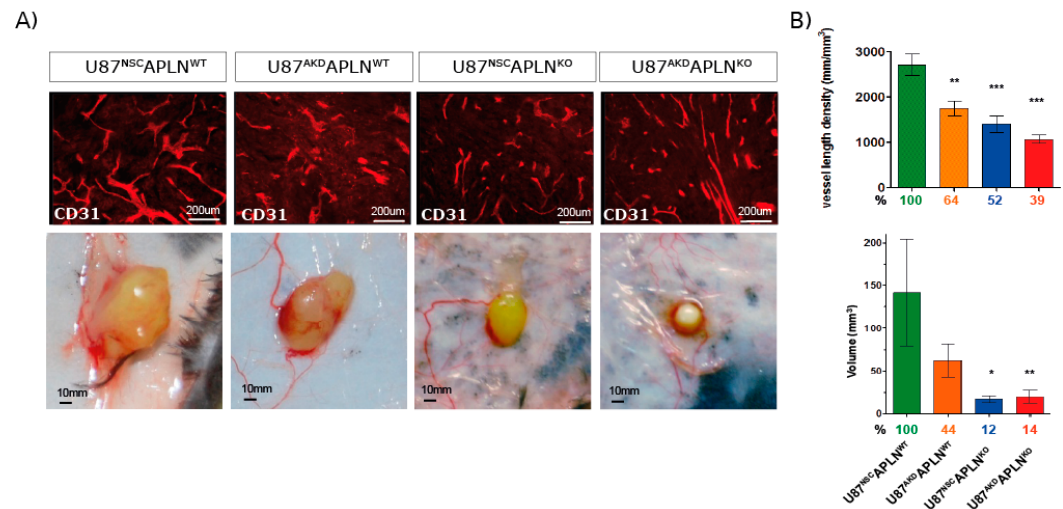
Figure 5. Apelin is required for compact tumor growth. Mice were inoculated subcutaneously with U87 cells and grown for 28 dpi. ( A ) Tumor volumes were measured, and vessel density was quantified on CD31-immunostained sections. Representative pictures of subcutaneous tumors are shown. ( B ) VLD and tumor volume was significantly attenuated upon reduction of APLN expression as compared to U87 NSC APLN WT controls (percentages compared to the control group are indicated). Tumor volumes were reduced to 50% in APLN knockdown U87 AKD APLN WT xenografts. Further reduction to less than 15% was observed in APLN KO mice. Number of cell implantations for U87 NSC APLN WT , U87 AKD APLN WT , U87 NSC APLN KO , U87 AKD APLN KO were n = 38, 31, 18, 24, while tumor take was 87%, 90% 72%, 50%, respectively. For VLD analysis n = 7, 6, 7, 6 of the respective xenografts were analyzed. Data are reported as mean +/ − SEM; statistical significance (one-way ANOVA plus Bonferroni´s post hoc test) is indicated * p < 0.05, ** p < 0.005, *** p < 0.0005.